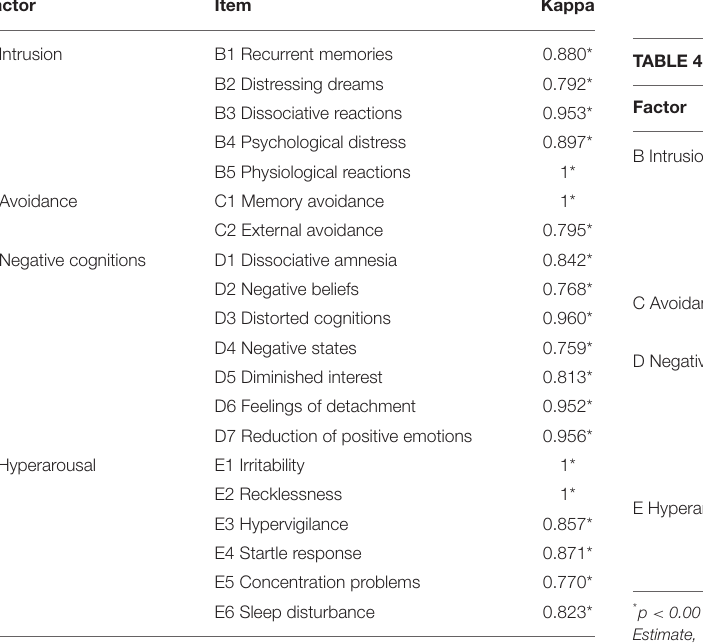
TABLE 2 | Inter-raterreliability coefficients of CAPS-5 ( n = 36).